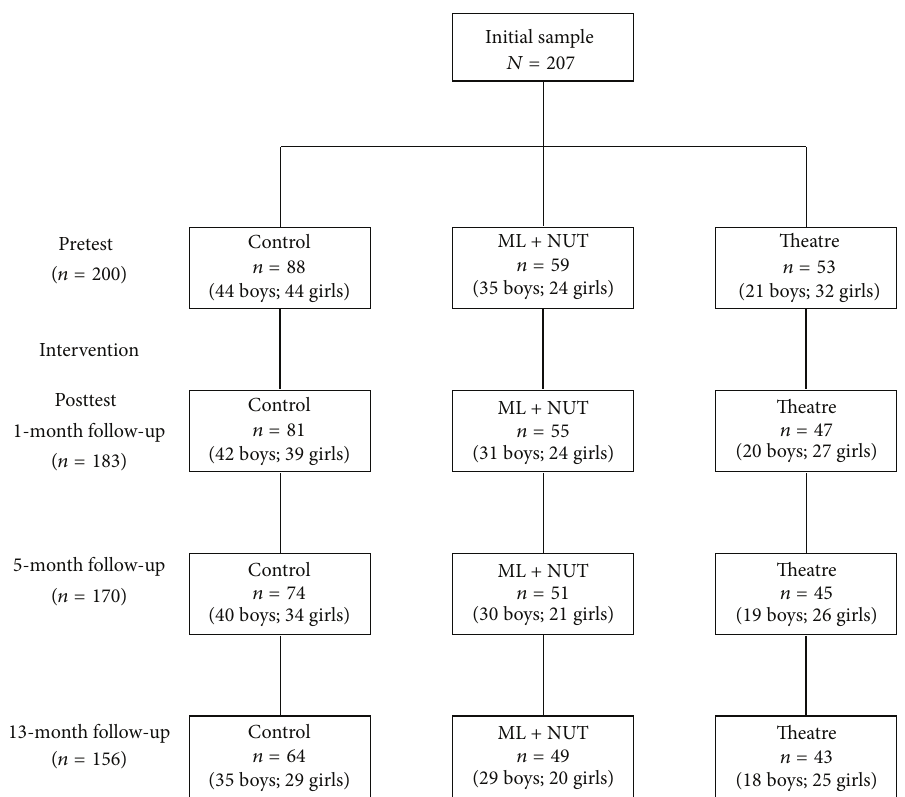
Figure 1: Flow diagram of progress through the phases of the